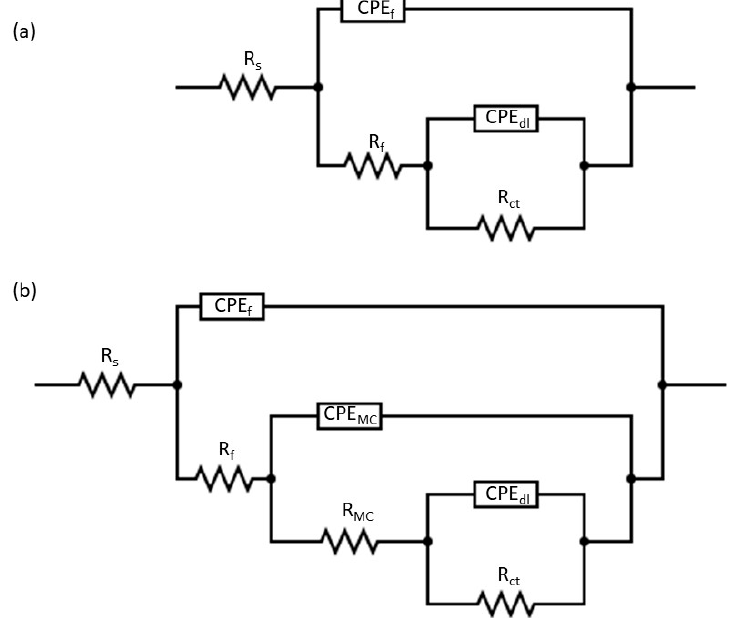
Figure 9. Electrical equivalent circuits used to fit EIS data for ( a ) coated specimens and ( b ) coated specimens with colophony microcapsules.